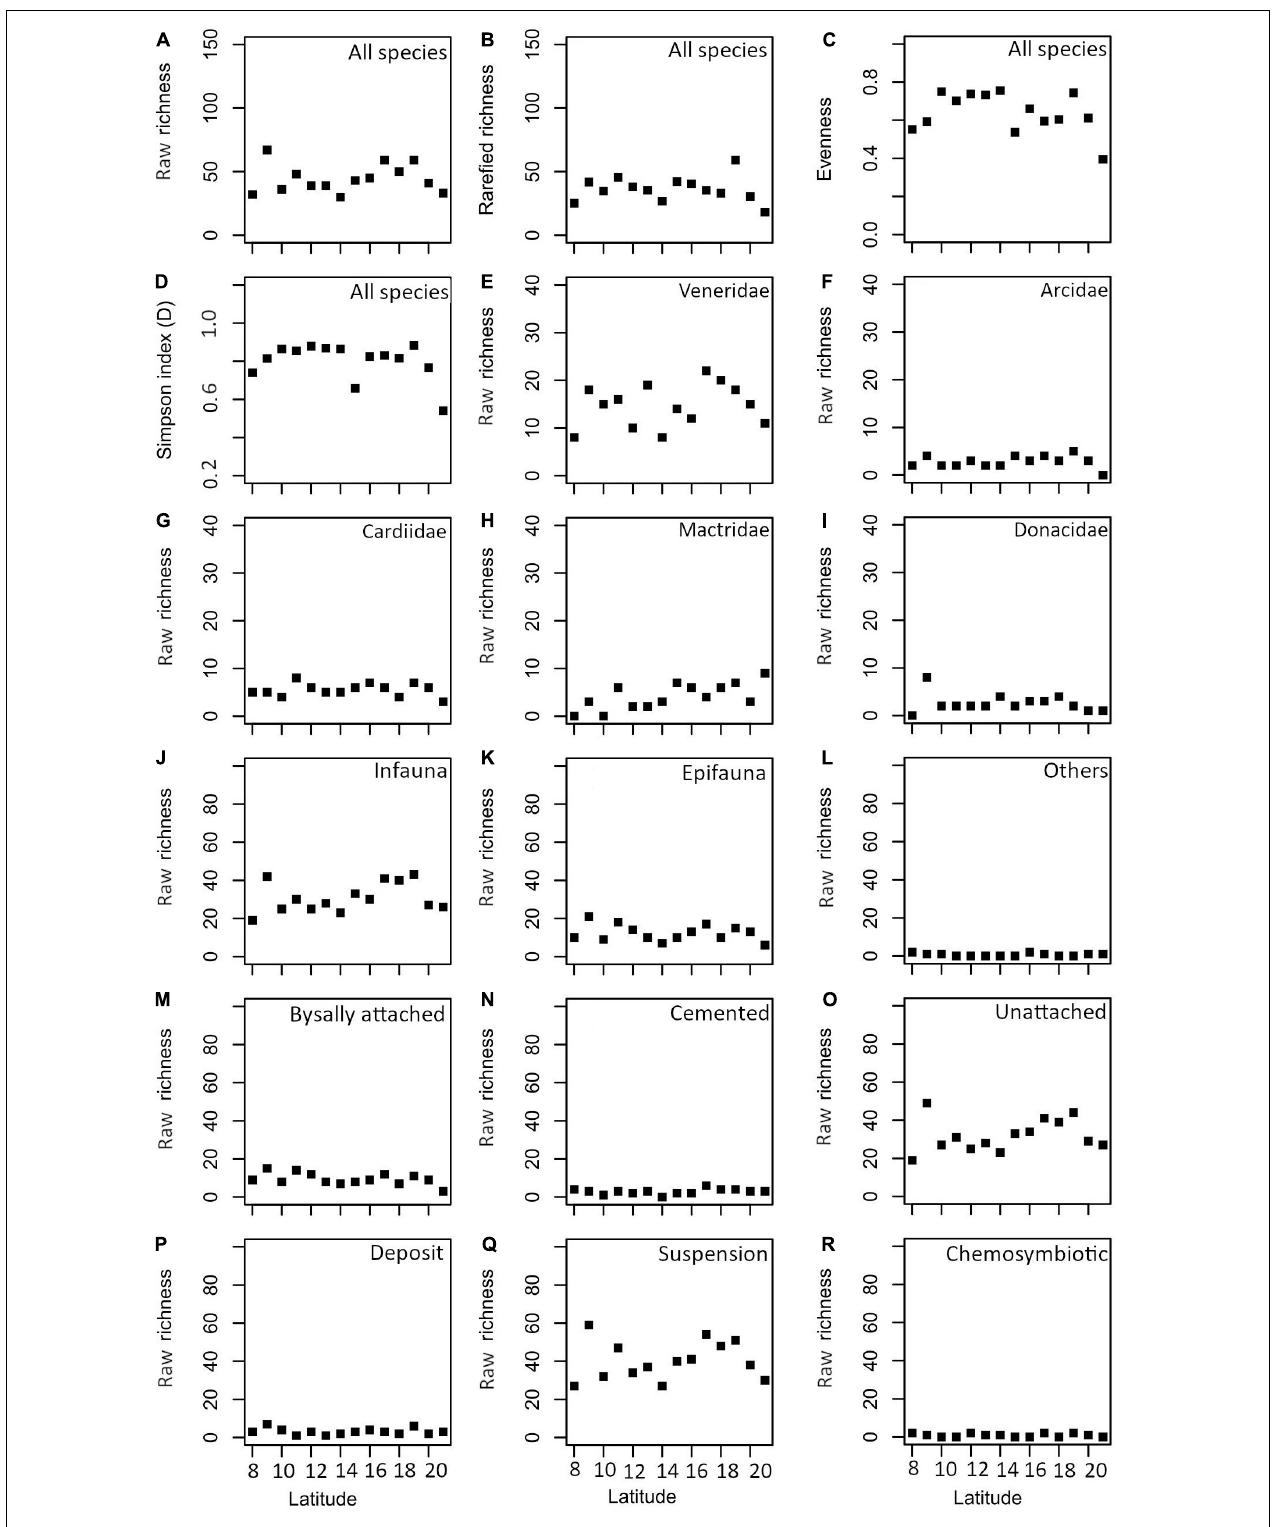
FIGURE 4 | Latitudinal variation in various diversity indices (A–D) , common families [ (E) Veneridae, (F) Arcidae, (G) Cardiidae, (H) Mactridae, and (I) Donacidae] and functional groups based on substrate relationship [ (J) infauna, (K) epifauna, and (L) others], attachment [ (M) byssally attached, (N) cemented, and (O) unattached] and feeding [ (P) deposit, (Q) suspension, and (R) chemosymbiotic].